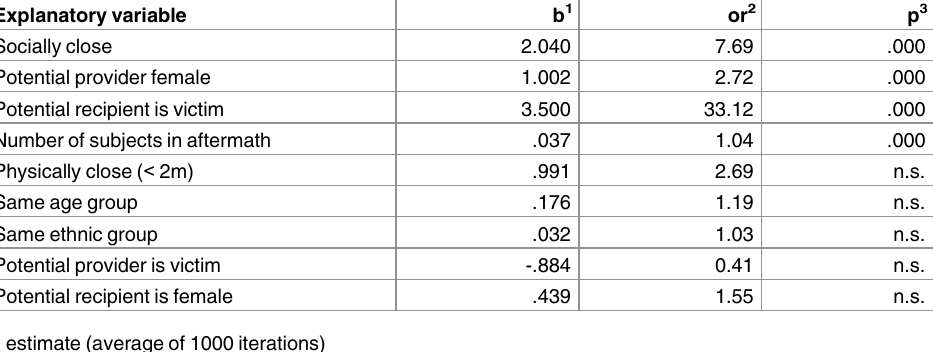
Table 2. Logit analysis of consolation among 3364 dyads 4 . Quadratic assignment procedure. Explanatory